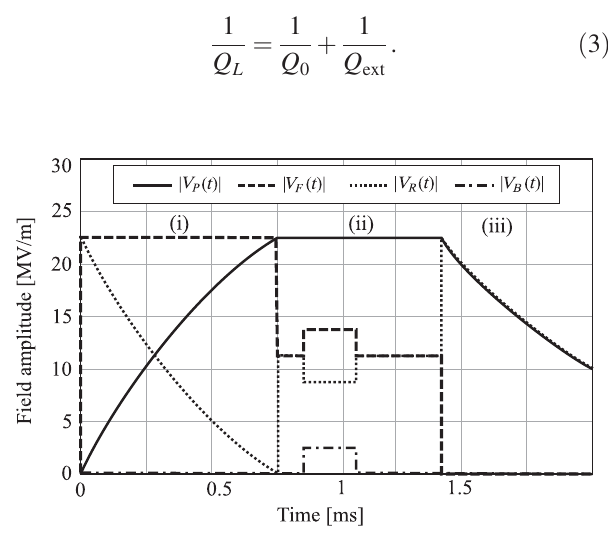
FIG. 1. Amplitude of the fields for the probe j V P ð t Þj , forward j V F ð t Þj and reflected j V R ð t Þj waveforms, and the field imposed by the beam j V B ð t Þj for the three regions of an rf pulse: (i) filling, (ii) flattop, and (iii)